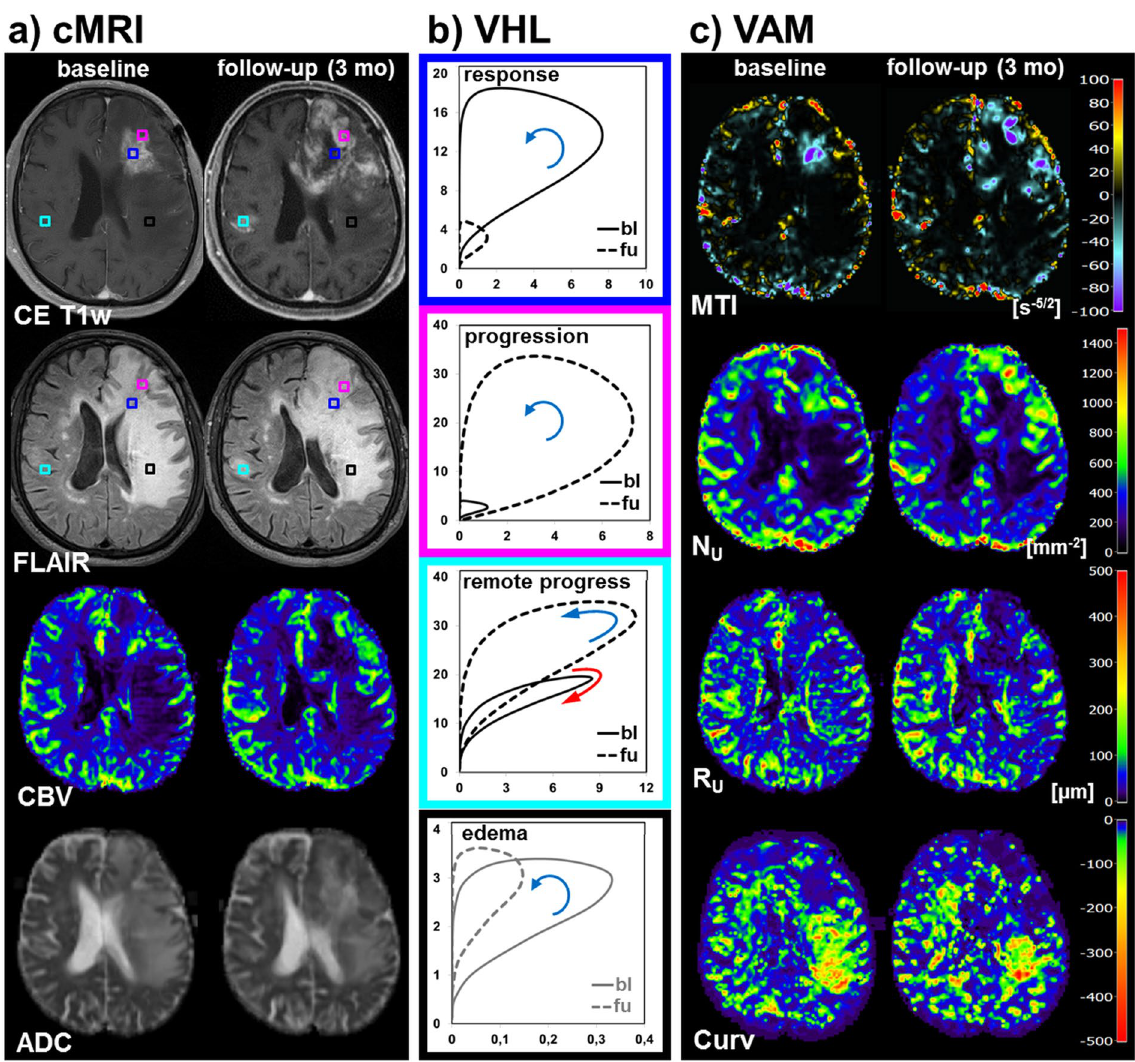
Figure 4. Vascular hysteresis loops and VAM biomarker maps for a 76-year-old male patient suffering from a recurrent glioblastoma before AAT onset (baseline, bl) and at 3-month follow-up (fu). ( a ) Conventional MRI (cMRI) included contrast-enhanced T1-weighted (CE T1w), FLAIR, GE-EPI DSC perfusion evaluated as maps of cerebral blood flow (CBV), and DWI evaluated as apparent diffusion coefficient (ADC), respectively. ( b ) 3/2 (x-axis) diagrams, for a voxel position in the responding tumor VHLs, i.e. the ∆ R (y-axis) versus ∆ R 2,GE 2,SE (blue-framed VHLs), tumor progression (magenta), remote progression (cyan), and for edema in the vicinity of the tumor progression (black). The voxel positions are marked with squares in the CE T1w and FLAIR images in ( a ) and have the same color as the frames of the VHLs. The arrows indicate the rotational direction of the VHLs. ( c ) The maps of the microvessel type indicator (MTI), the upper limit for microvessel density (N U ) and radius (R U ) adapted to the temporal shift phenomenon, and the curvature (Curv) of the VHL (top-down). The color codes are depicted at the right image